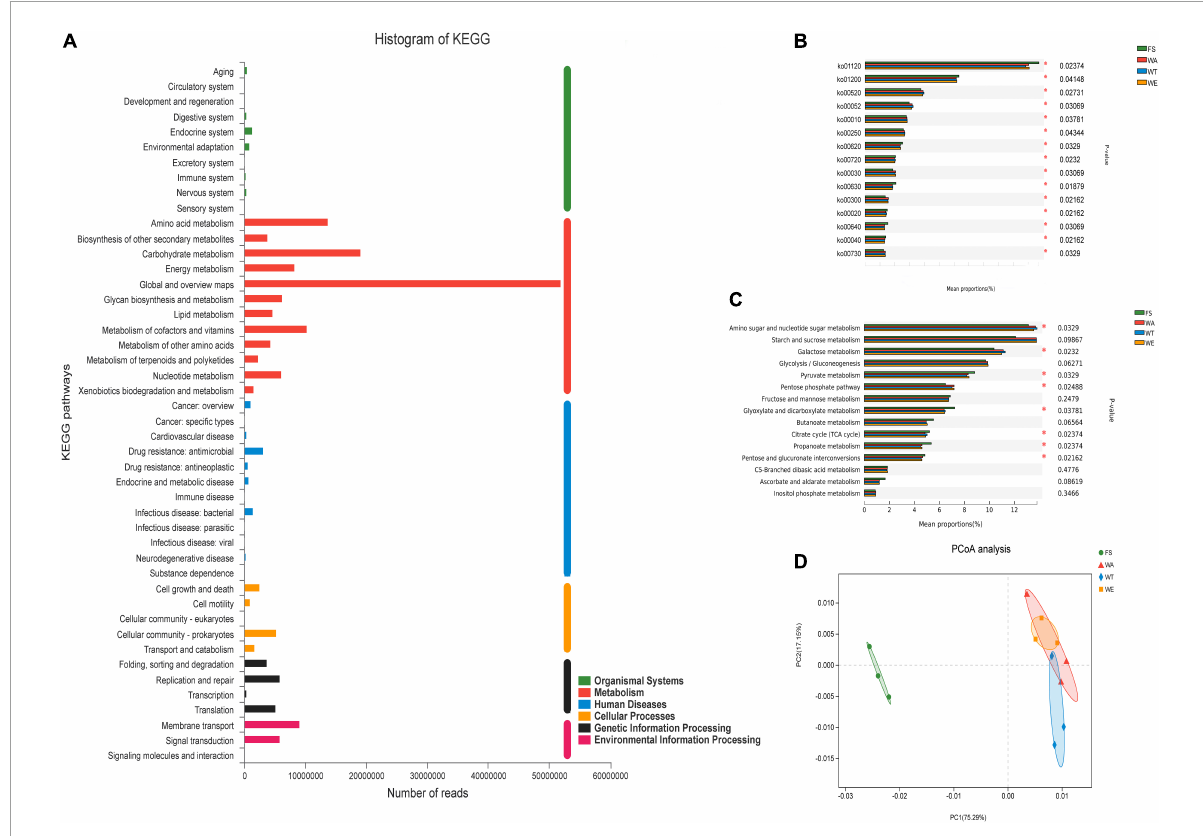
FIGURE3 Composition of the KEGG system and analysis of differences between groups. (A) Distribution of annotated genes of cereals mixture samples in KEGG; (B) Comparison of multiple groups of metabolism pathway at the second level of KEGG; (C) Comparison of multiple groups of carbohydrate metabolism pathway at the third level of KEGG; (D) Principal coordinate analysis (PCoA) of